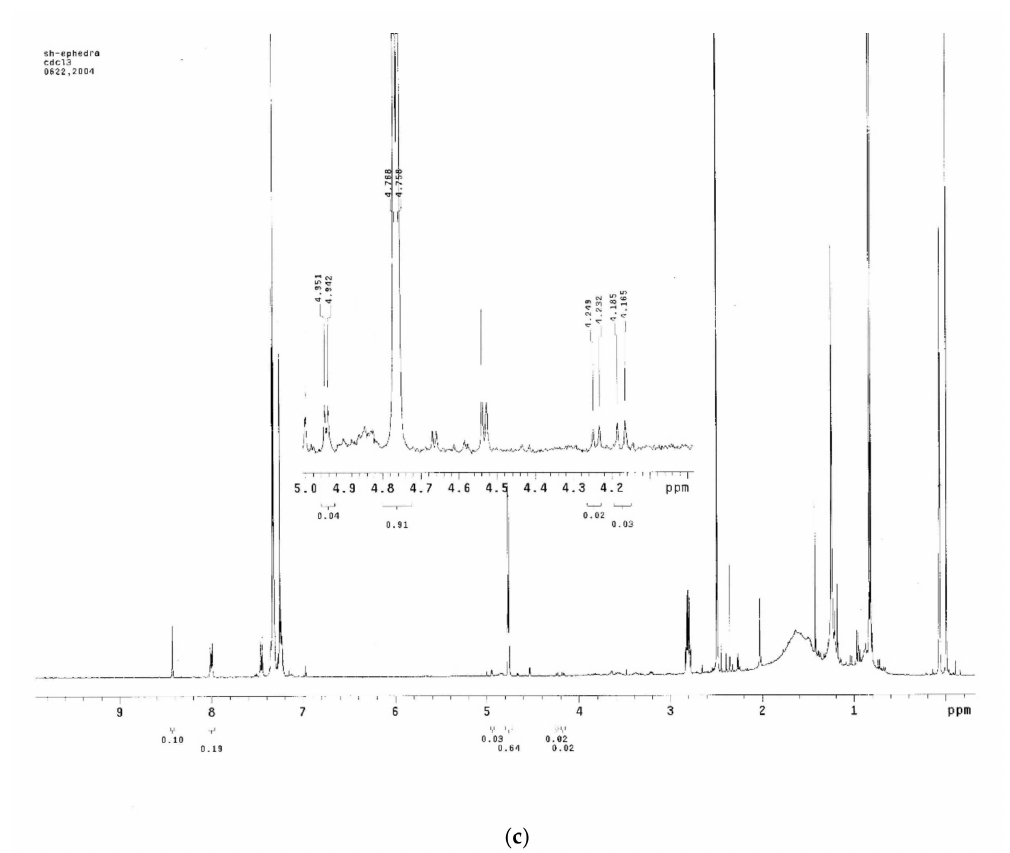
Figure 2. The 1 H-NMR spectra of three Ephedra extracts. ( a ) E. sinica (ES); ( b ) E. intermedia (EI); and ( c ) E. equisetina (EE).